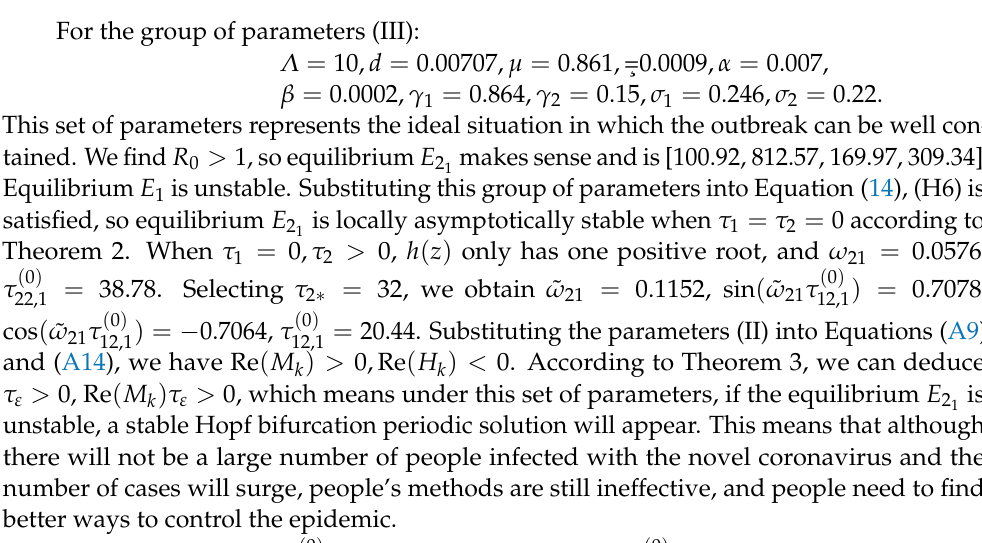
of System (1) is locally asymptotically 1